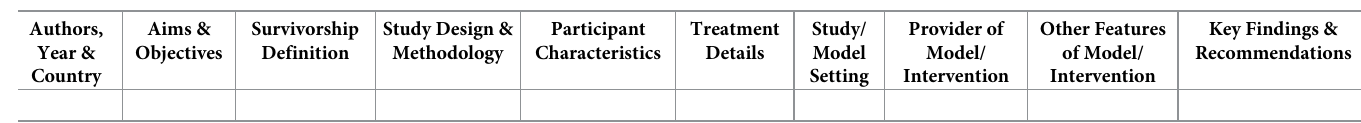
Table 2. Data extraction